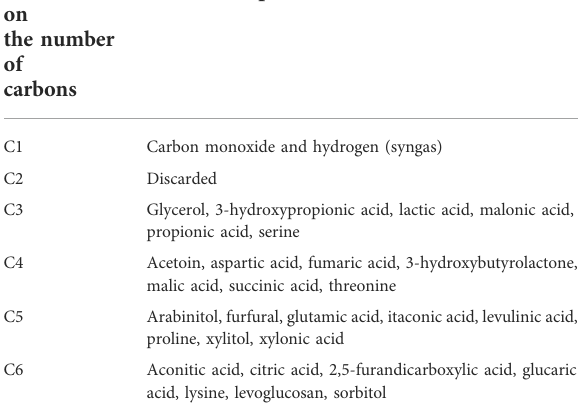
TABLE 2 Bio-based chemical building blocks as identi fi ed by the U.S. Department of Energy in 2004. Label based on